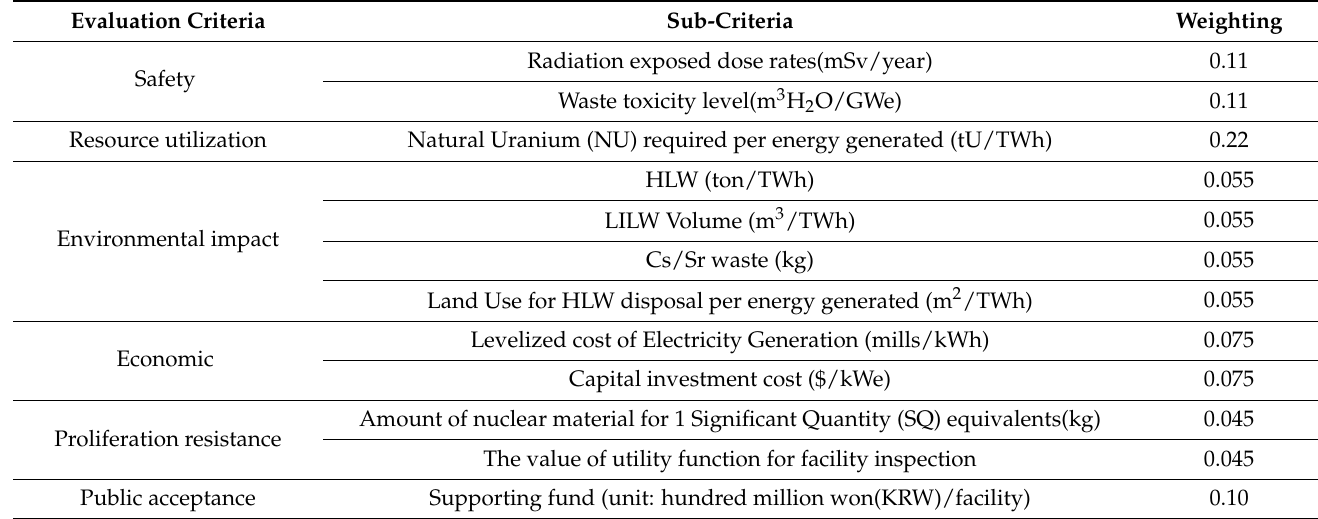
Table 3. Rank-reciprocal weight of evaluation index [8].